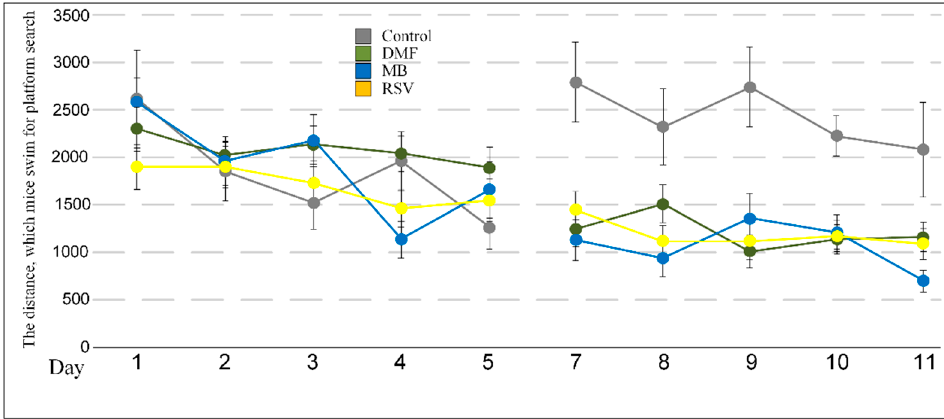
Figure 3. The distance that mice swam for the platform search during acquisition and reversal learning. The results expressed as means ± SEM. Control n = 8, DMF = 9, MB = 6, RSV = 8.